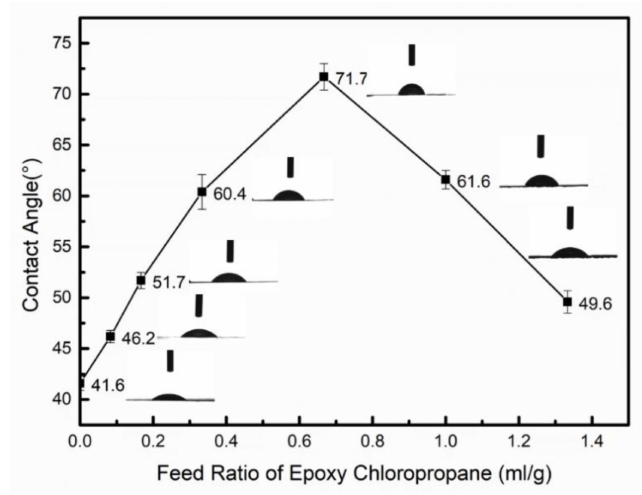
Figure 10. Contact angle results of modified hemicellulose